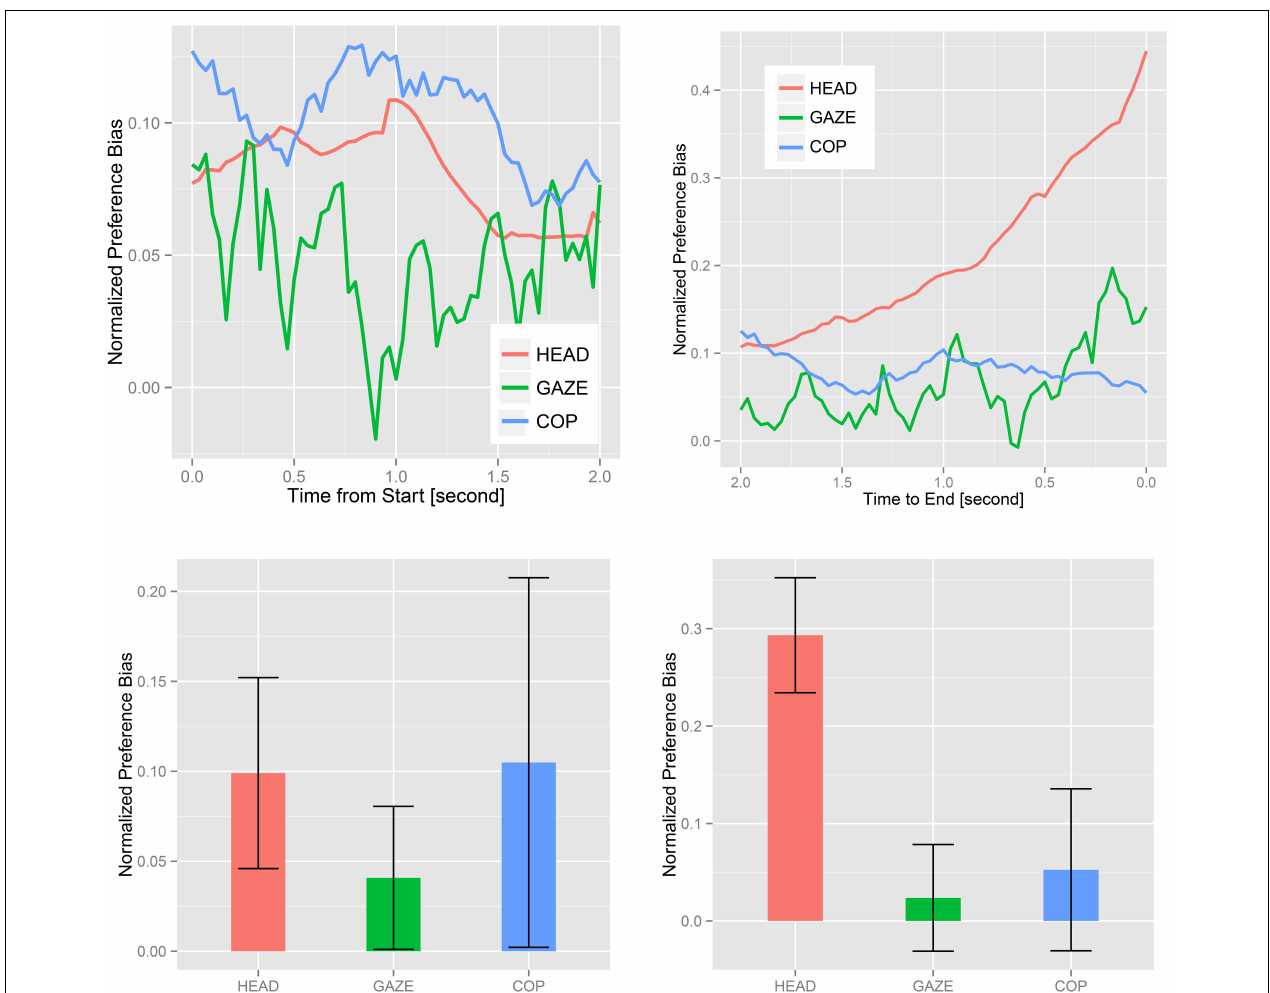
FIGURE 6 | Top: plots of normalized preference bias aligned at the beginning time (left) and at the ending time (right) averaged over all samples in case 1 . Bottom : bar-plots of the samples averaged over the beginning (left) and the ending (right) 1s with standard errors in case 1